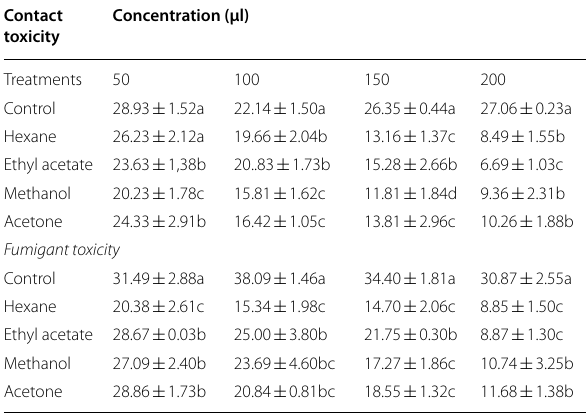
Table 1 Effect of Secamone afzelii extracts on percentage adult emergence